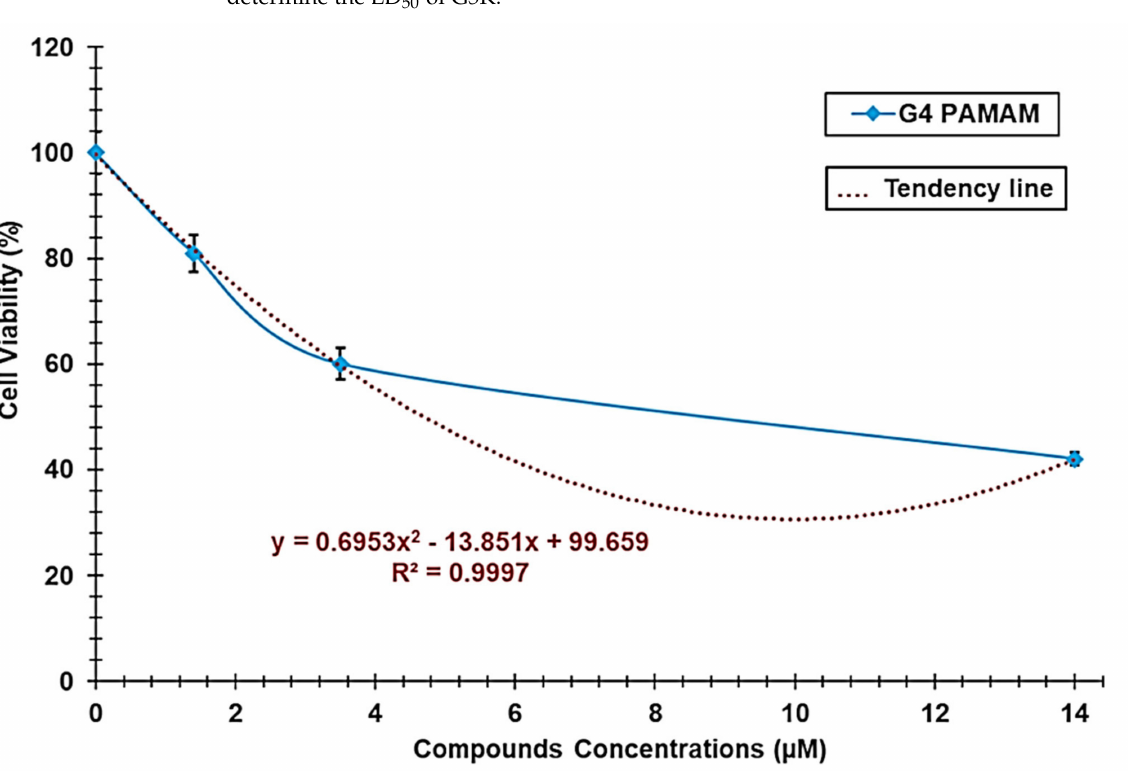
Figure 3. Viability (%) of HeLa cells exposed for 24 h to G4-PAMAM-NH 2 0–14 µ M and the associated polynomial trend line with Equation (7) used to determine the LD 50